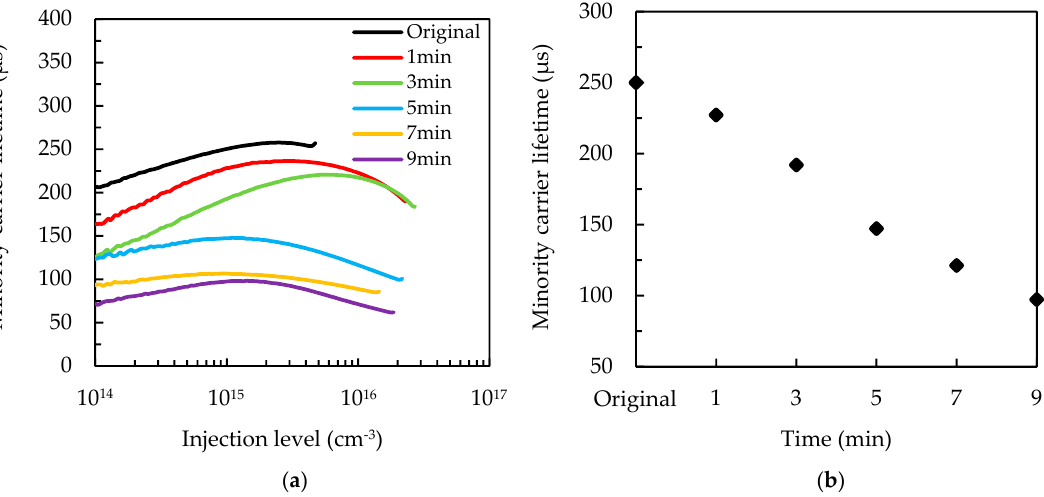
Figure 6. ( a ) Injection-level dependent minority carrier lifetime, and ( b ) average minority carrier lifetime at the injection level of 3 × 10 15 cm − 3 for the SiN x /Al 2 O 3 -passivated silicon wafers with a different MACE time. The labeled “Original” refers to the passivated wafer with only alkaline etching but without the MACE process.